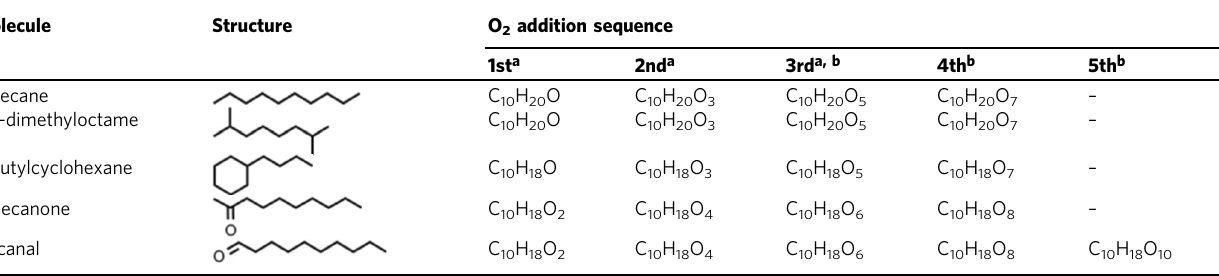
The listed molecules correspond to the carbonyl (R = O) termination products of RO 2 radicals. For all compounds a 4th O 2 addition was observed, and for decanal even a 5th O 2 addition took place. a Measured by SVUV-PIMS in Wang et al. 6 b Measured by CI-APi-TOF in this